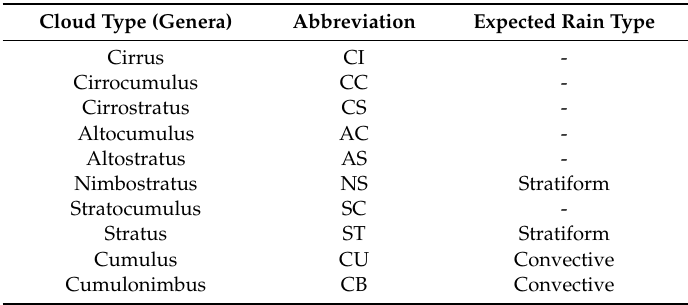
Table 1. Cloud types and their associated expected rain